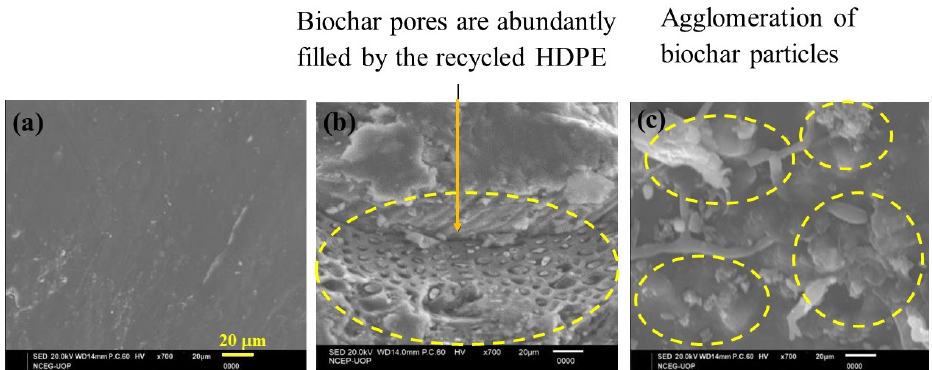
Figure 3. SEM images of ( a ) unmodified recycled HDPE, ( b ) 30% rice husk reinforced recycled HDPE, and ( c ) 40% rice husk reinforced recycled